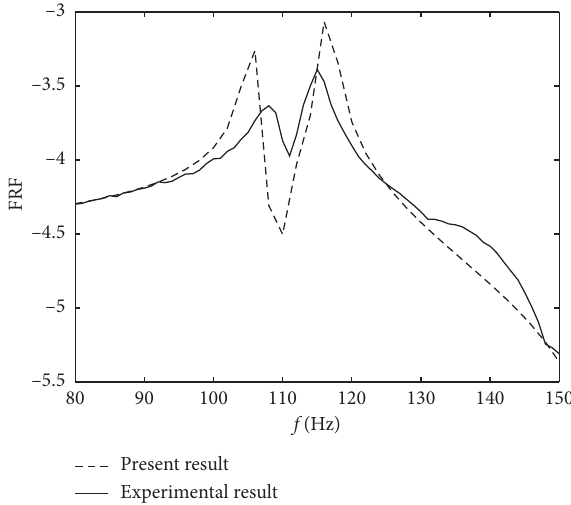
Figure 3: Comparison between experimental and present result.